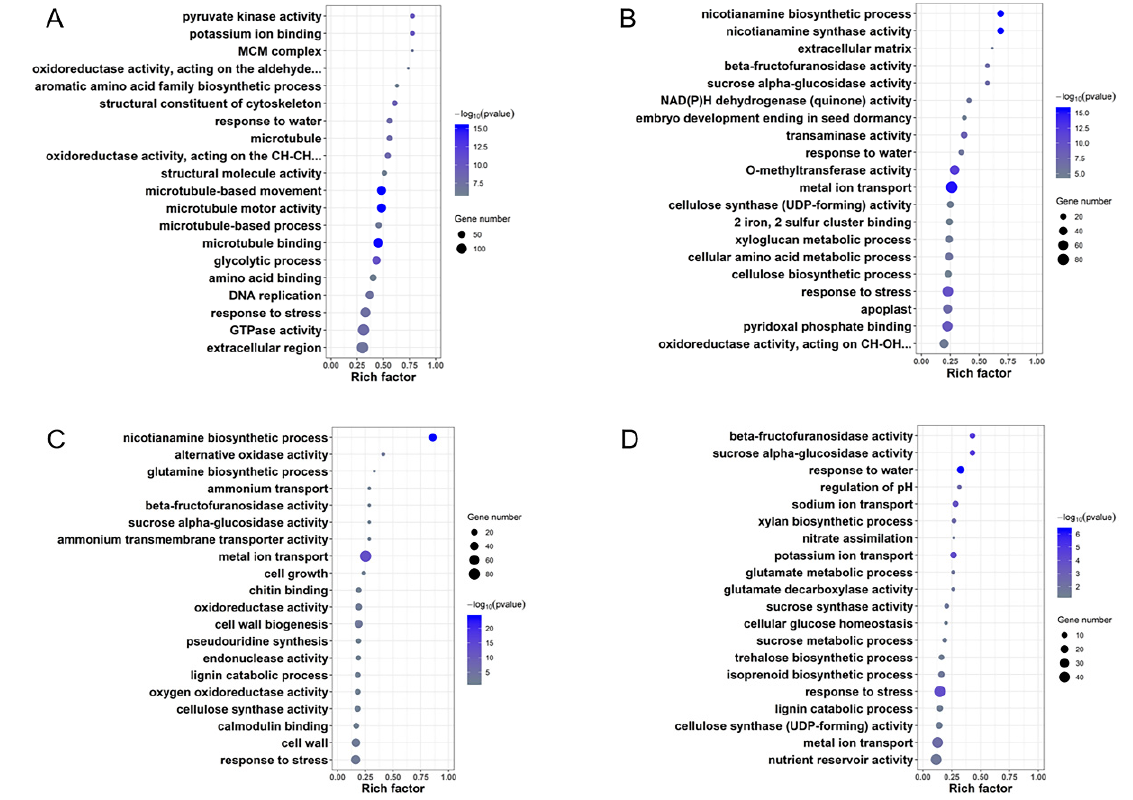
Figure 5. Gene ontology (GO) enrichment analysis of four groups of DEGs. The 20 representative enriched GO terms of ( A ) general ABA-responsive genes, ( B ) cultivar-preferential ABA-responsive genes, ( C ) endogenous cultivar-preferential genes, and ( D ) exogenously cultivar-preferential ABA- responsive genes. The X-axis is the rich factor calculated by dividing the number of DEGs by the total number of genes in a certain pathway. The size and color of the bubbles indicate the gene number and enrichment significance, respectively.